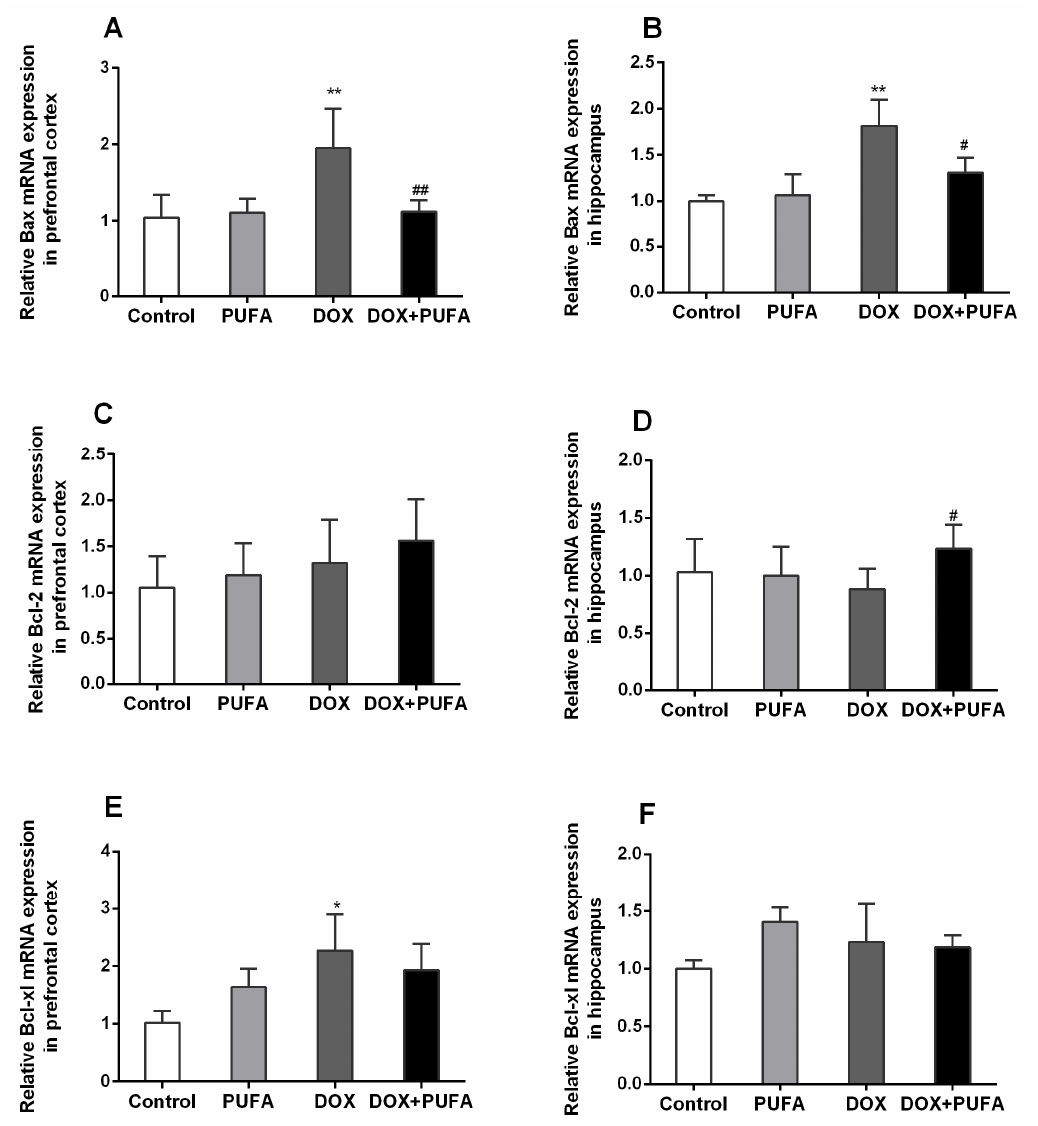
Figure 7. Effects of DOX and ω -3 PUFAs on gene expression of Bax, Bcl-2, and Bcl-xl in the prefrontal cortex and hippocampus. Data are expressed as means ± SD ( n = 6–7). * p < 0.05, ** p < 0.01 compared to the control group. # p < 0.05, ## p < 0.01 compared to the DOX-injected group.